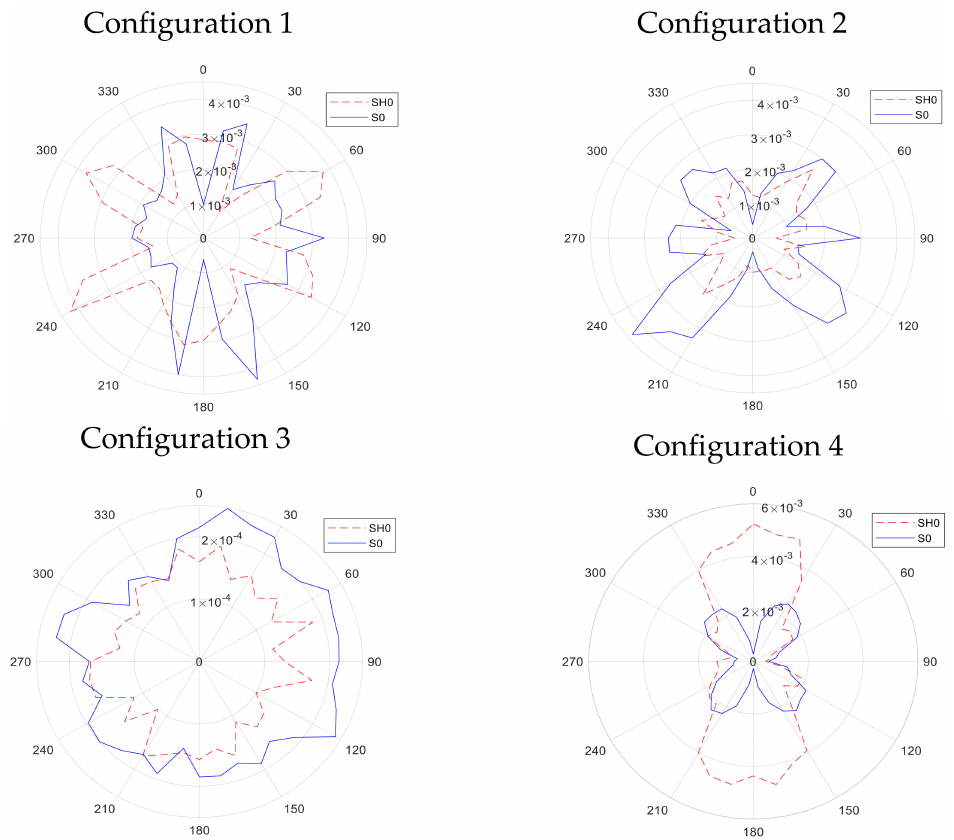
Figure 14. Directivity patterns for S0 and SH0 modes generated on the metallic plate for Configurations 1, 2, 3 and 4 as labelled in the